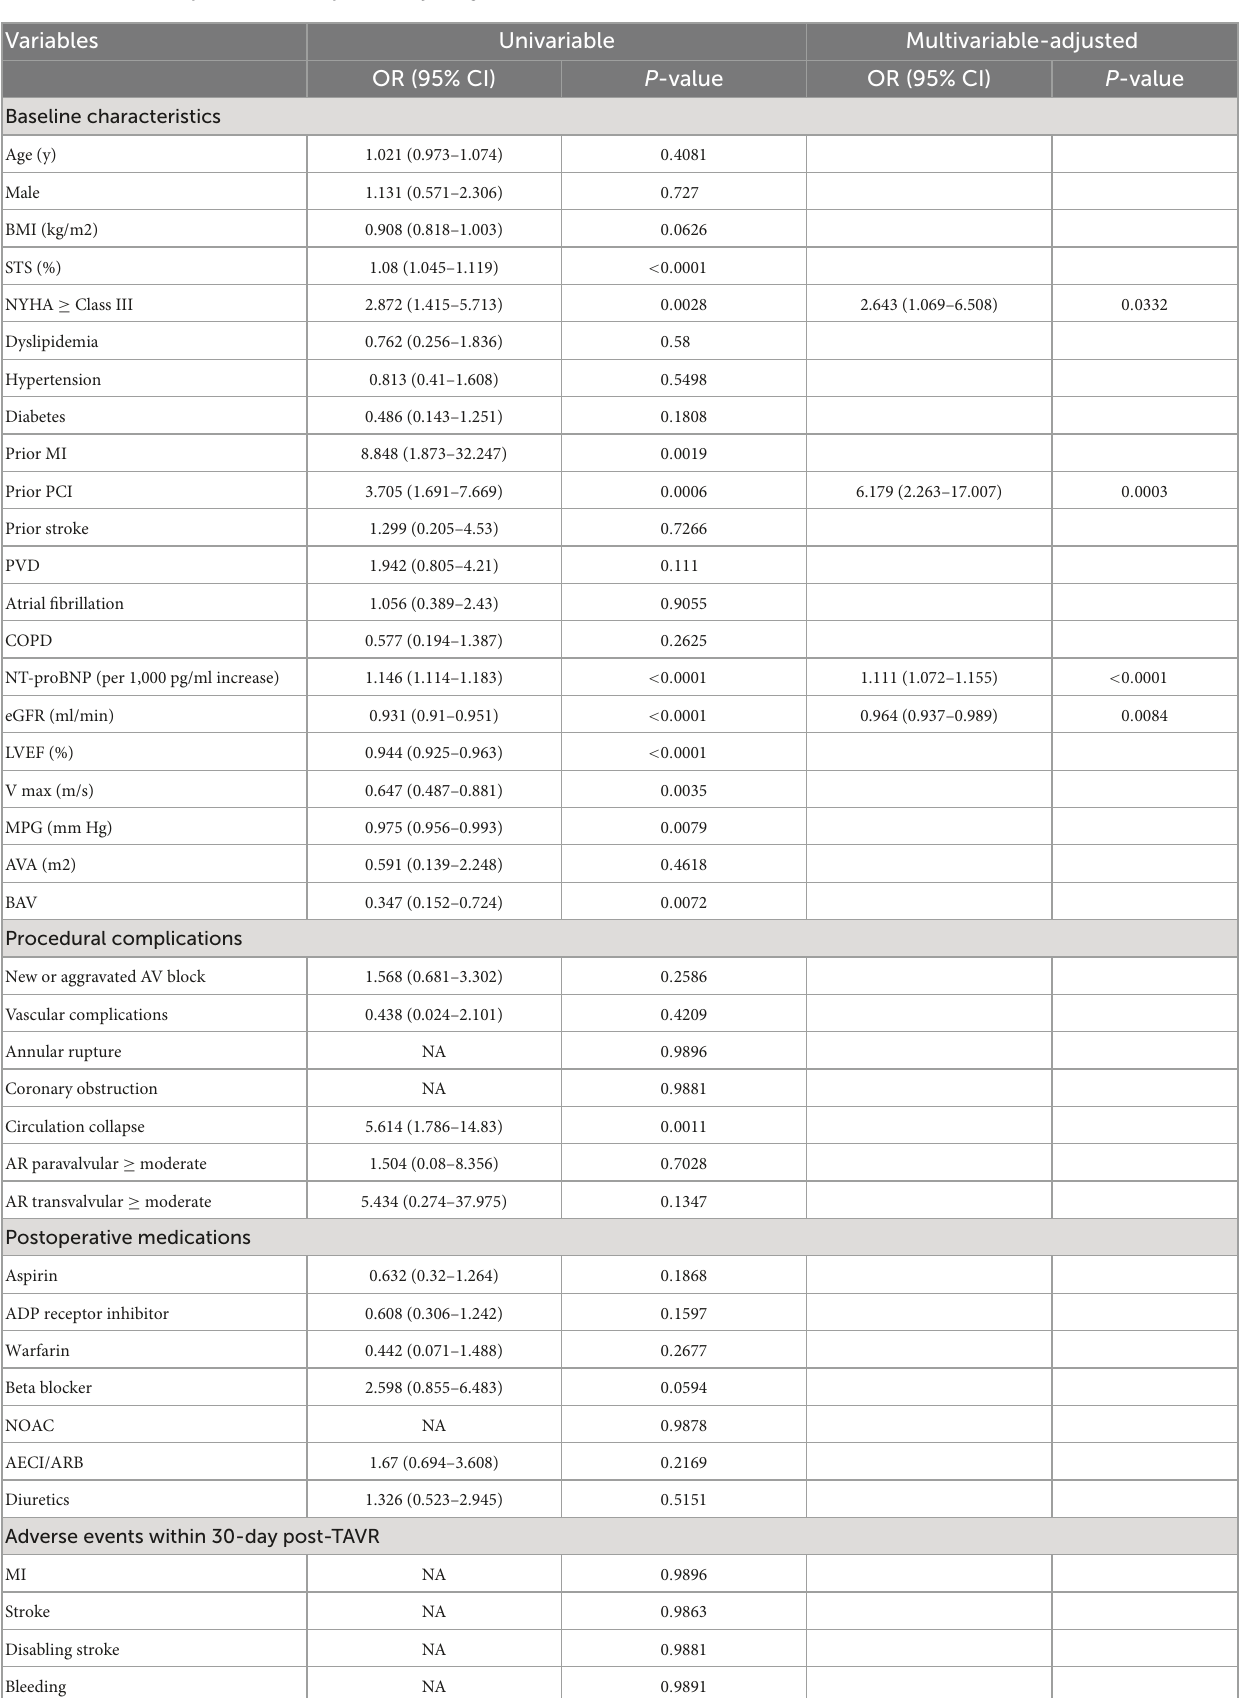
TABLE 3 Multivariable predictors of NT-proBNP trajectory class three after TAVR.